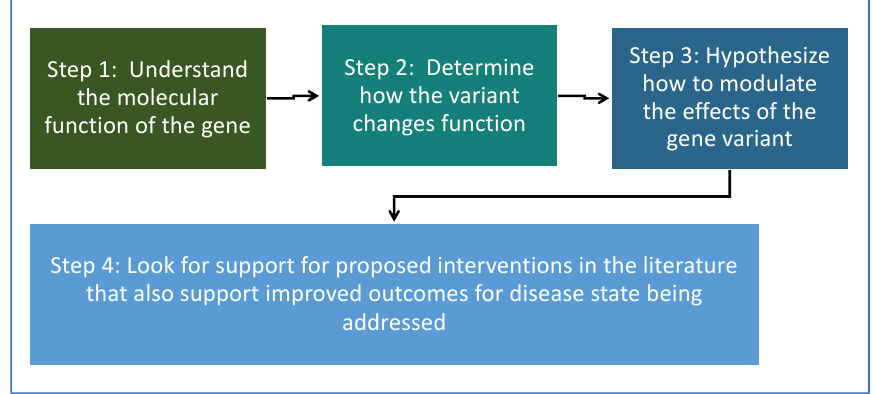
Figure 1. Overview of the approach used, from identification of a gene variant to presentation with potential interventions in the CDS.